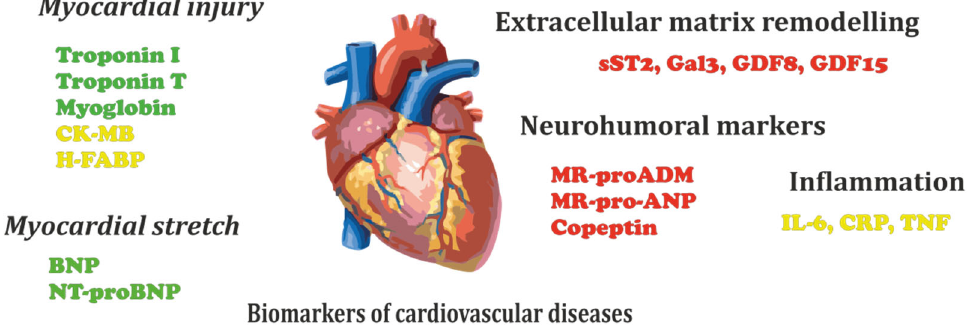
Figure 1. Classification of cardiac biomarkers (adopted from reference [3]). CK-MB—creatine kinase; BNP—B-type natriuretic peptide; NT-proBNP—N-terminal pro-B-type natriuretic peptide; MR-proADM—mid-regional proadrenomedullin; MR-proANP—mid-regional pro-atrial natriuretic peptide; IL-6—interleukin-6; CRP—C-reactive protein; TNF α —tumor necrosis factor alpha; sST2—soluble suppression of tumorigenicity 2; Gal3—galectin-3; GDF8—growth differentiation